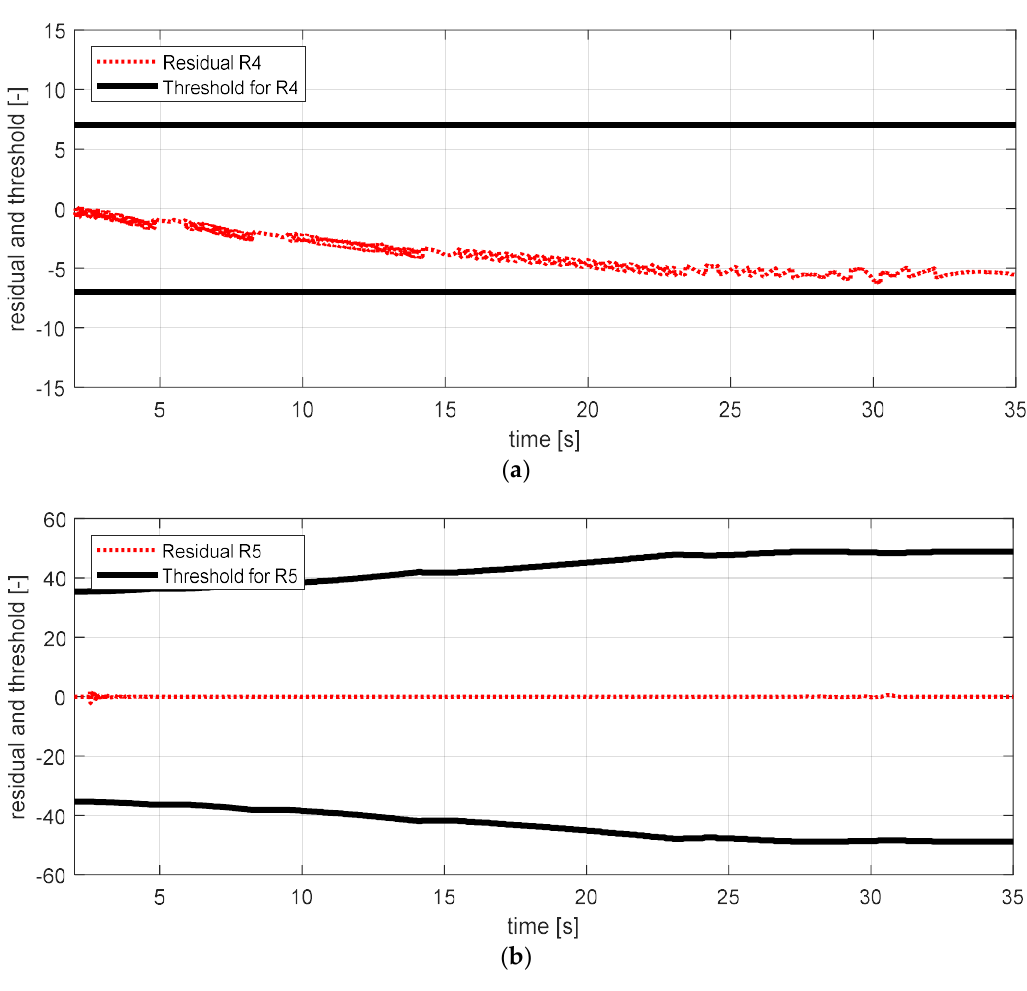
Figure 25. FDI simulation result for wheel angular speed sensor—rr (normal). ( a ) Residual 4 and threshold; ( b ) residual 5 and threshold.